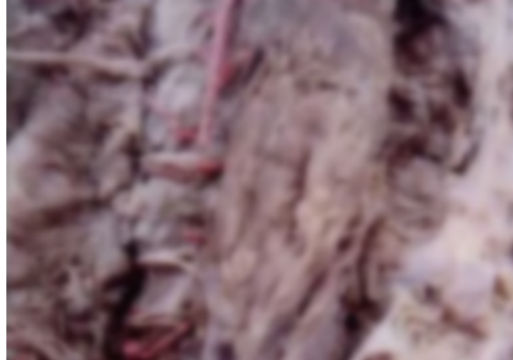
Figure 1. The results of anatomical image acquisition of cervical radiculopathy